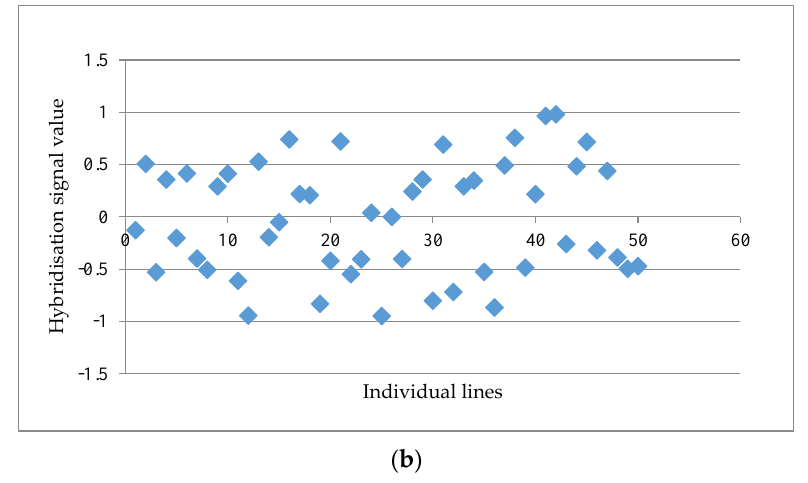
Figure 1. Examples of the ‘expression trait’ distribution of ‘a’ and ‘b’ allele scores across the individual lines at the unmasked probe-set level. ( a ) The probe set ‘GmaAffx.92555.1.S1_s_at’ with a distinctness score of 4.03 and ( b ) probe set ‘GmaAffx.57563.1.S1_at’ with a distinctness score of 2.15. The hybridisation signal value was normalised using GeneSpring GX. Allele ‘a’ (above the mid-point of the hybridisation scale axis, in these cases) was inherited from Tiga Nicuru, while allele ‘b’ was from DipC. Note the data point in (a) at the mid-point, which was scored as missing data, but could represent a